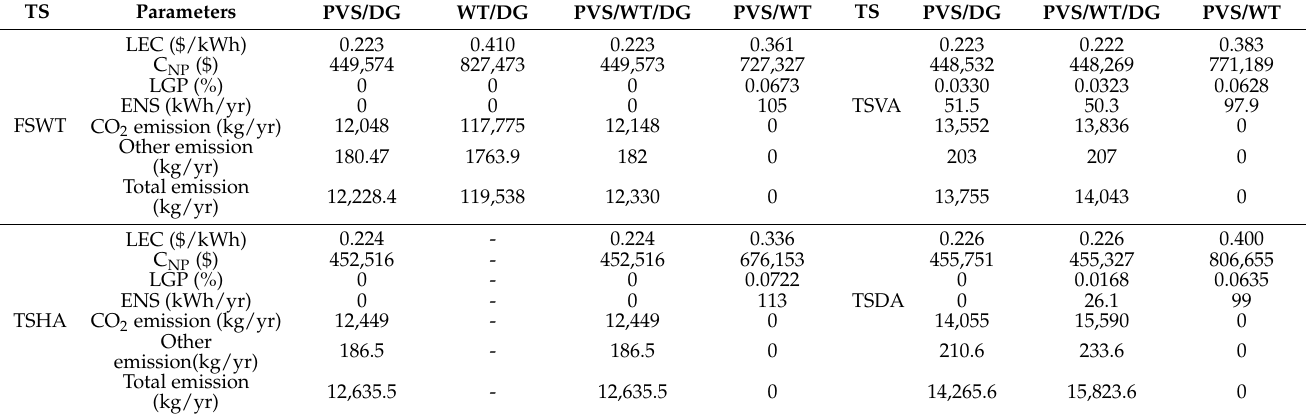
Table 5. Cost, reliability and emission analysis for various configurations with different